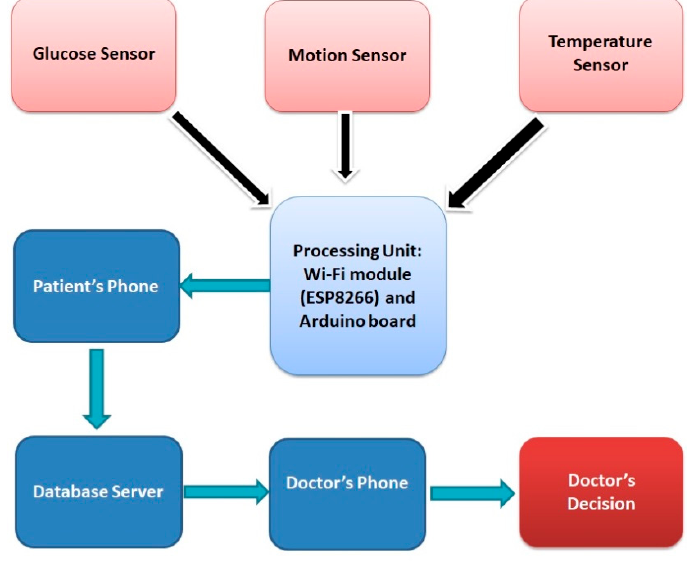
Figure 2. Hardware Block Diagram.